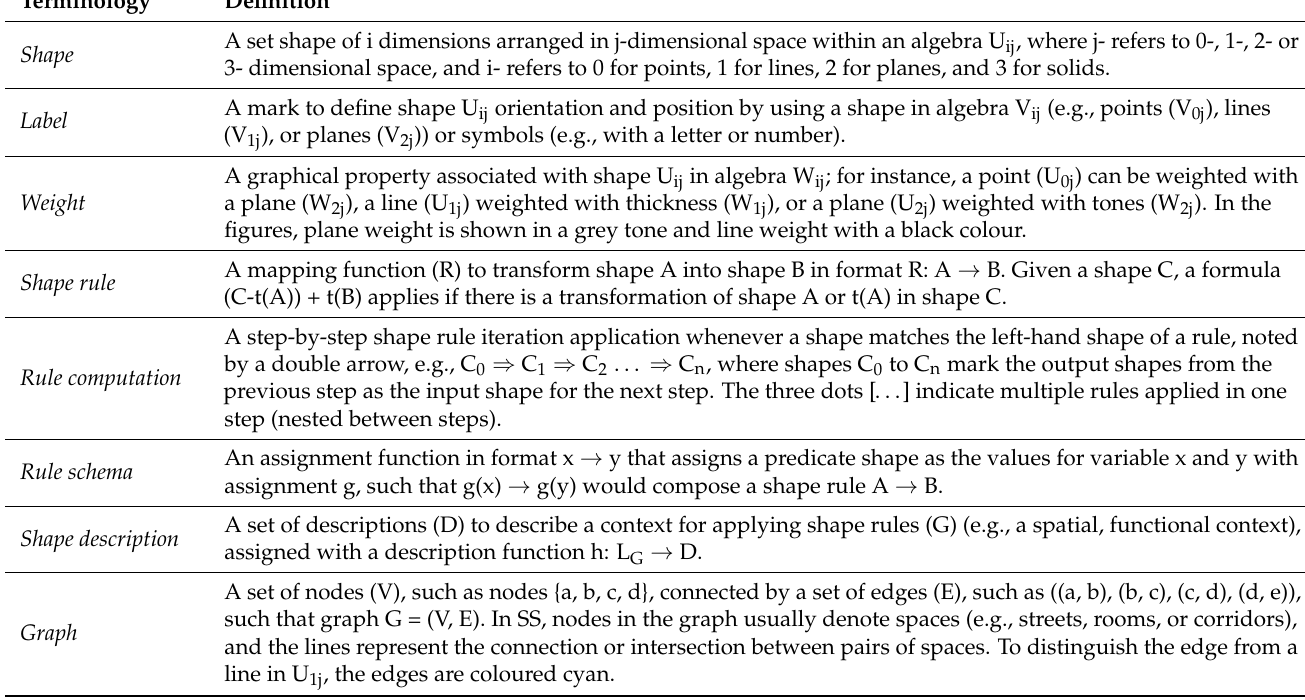
Table 1. Glossary. Readers can find further information on this terminology in [15,42,43] for SG and [10,44,45] for